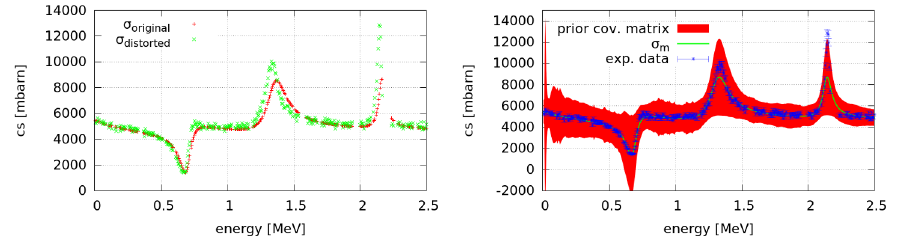
(cid:112) A 0 ( E j , E j )